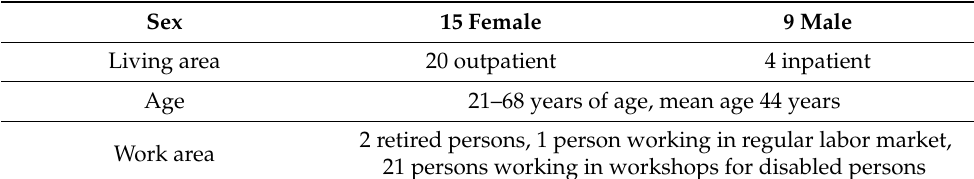
Table 1. Demographics of interview